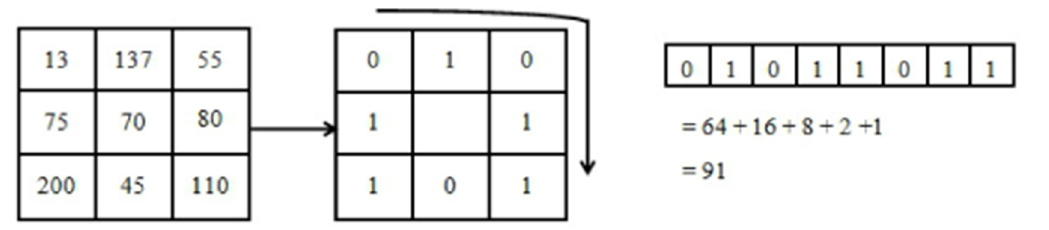
Figure 6. Complete process of the local binary pattern (LBP).